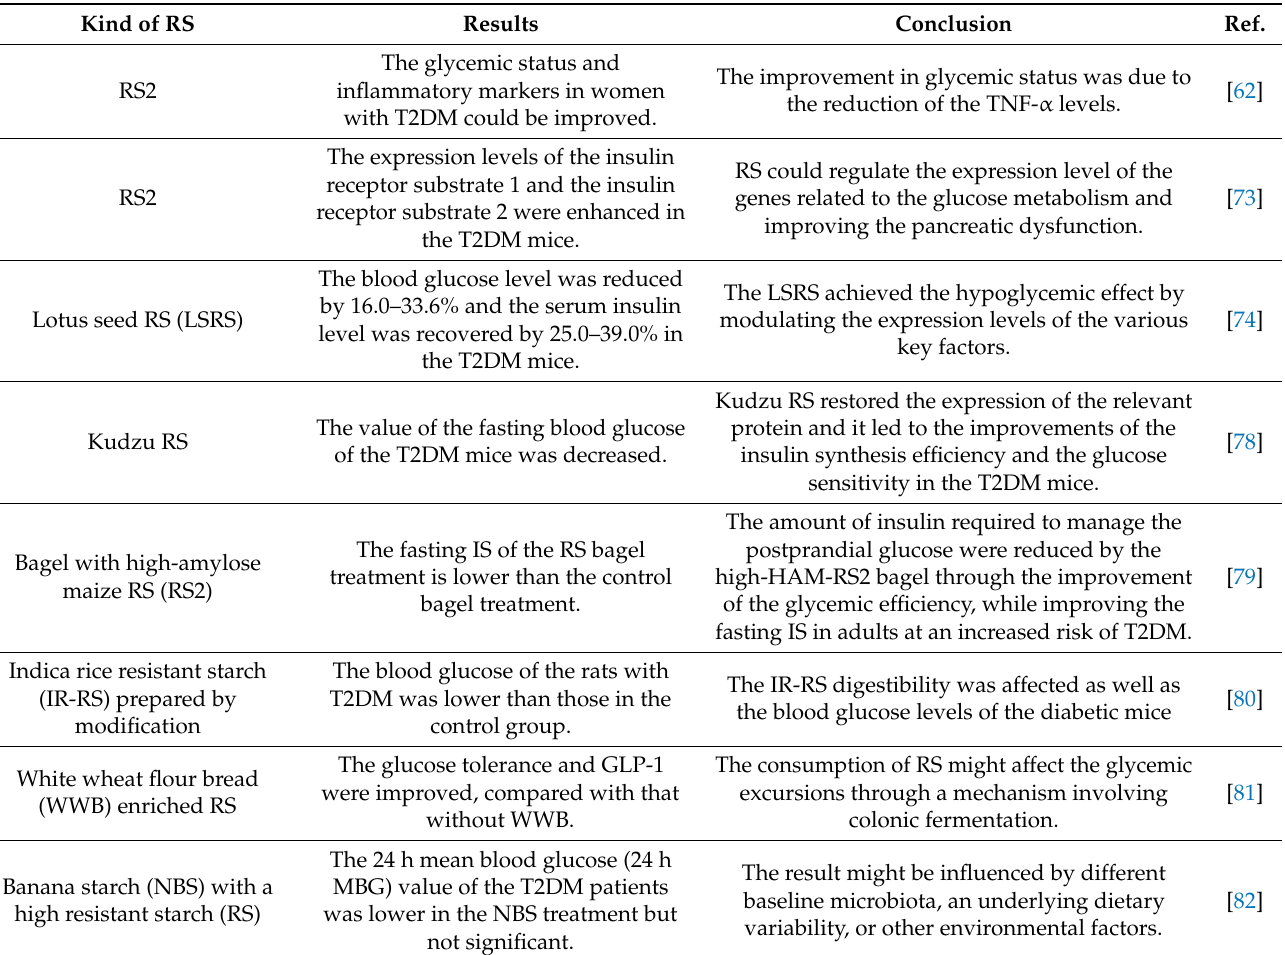
Table 2. Studies on the prevention of T2DM by